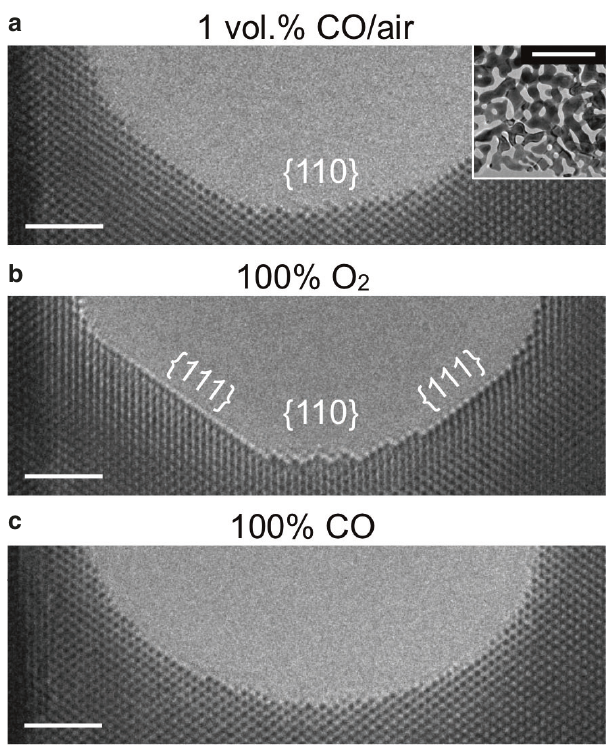
Fig. 1 Drastic changes in surface morphology around a pore in NPG. a